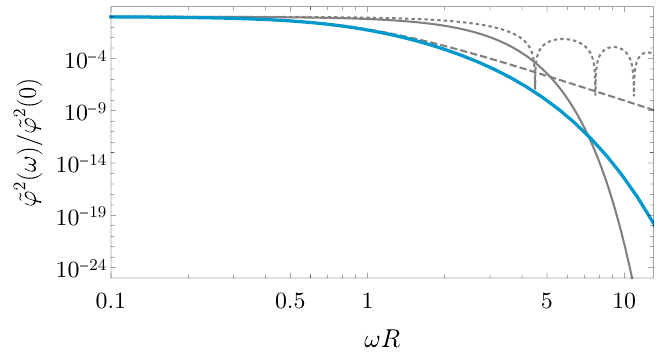
Figure 4 . The form factor F ( ω ) = ˜ ϕ 2 ( ω ) / ˜ ϕ 2 (0) , where ω is the frequency of oscillation of the axion field (and of the emitted electromagnetic radiation), and ˜ ϕ ( ω ) is the Fourier transform of the soliton’s spatial profile at k = ω . This form factor determines the amplitude of the dipole radiation, and has a very strong dependence on the radius of the soliton. The blue curve corresponds to the sech profile ∝ sech ( r/R ) , with the correct exponential behaviour at large R . The solid gray curve is for a Gaussian profile ∝ e − r 2 /R 2 , the dashed one for an exponential profile ∝ e − r/R with a cusp at the origin, and the dotted line correspond to a top-hat profile of the soliton with radius R . While the form factor is identical at small ωR for the different profiles, it is very sensitive to the profile choice at large ωR